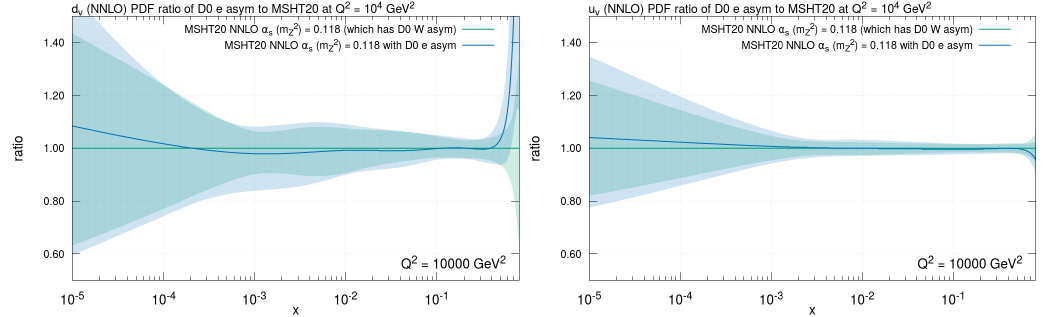
Figure 2: The effect of inclusion of D0 W asymmetry data compared to e asymmetry data for d (left) and u v V